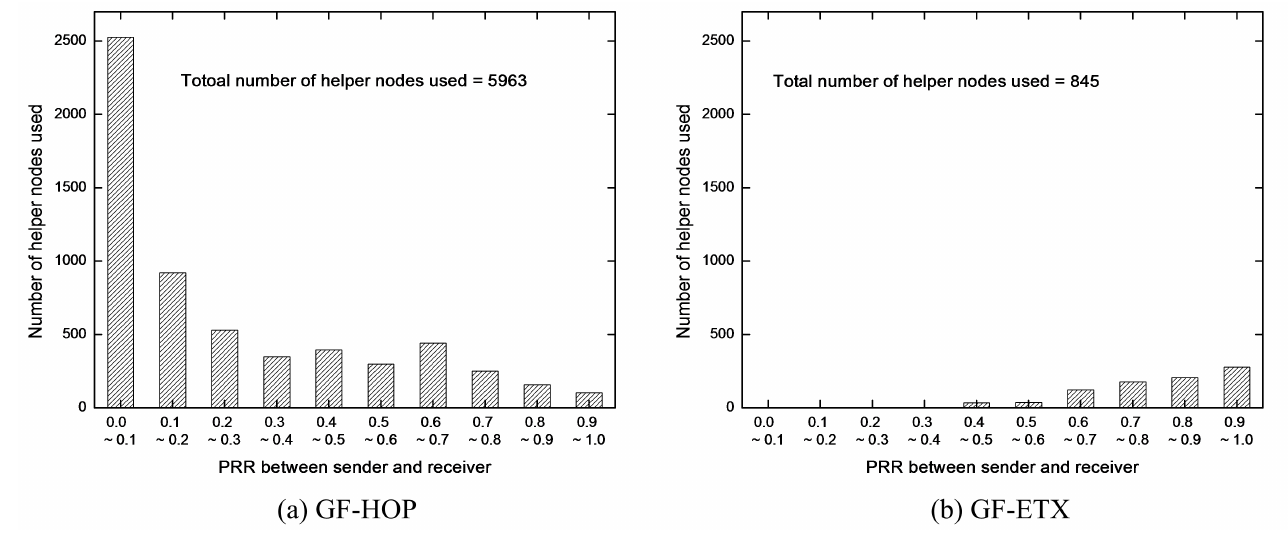
Figure 6. Number of helper nodes used at different